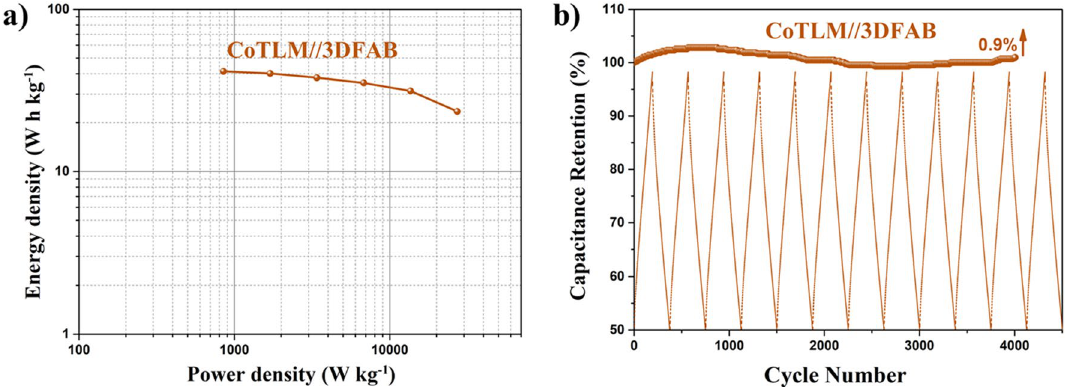
Figure 11. Cycle performance of 3DFAB//CoTLM electrode at the current density of 4 A g −1 ( a ), Ragone plot of 3DFAB//CoTLM ( b ).